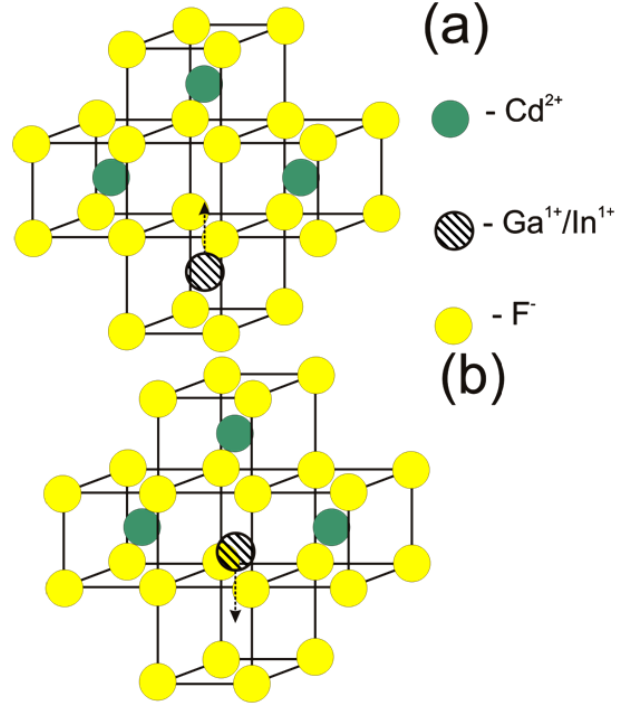
Figure 2. Displacement of a bistable impurity ion at ( a ) formation of a deep center; and ( b ) conversion of a photoionized deep center into a shallow